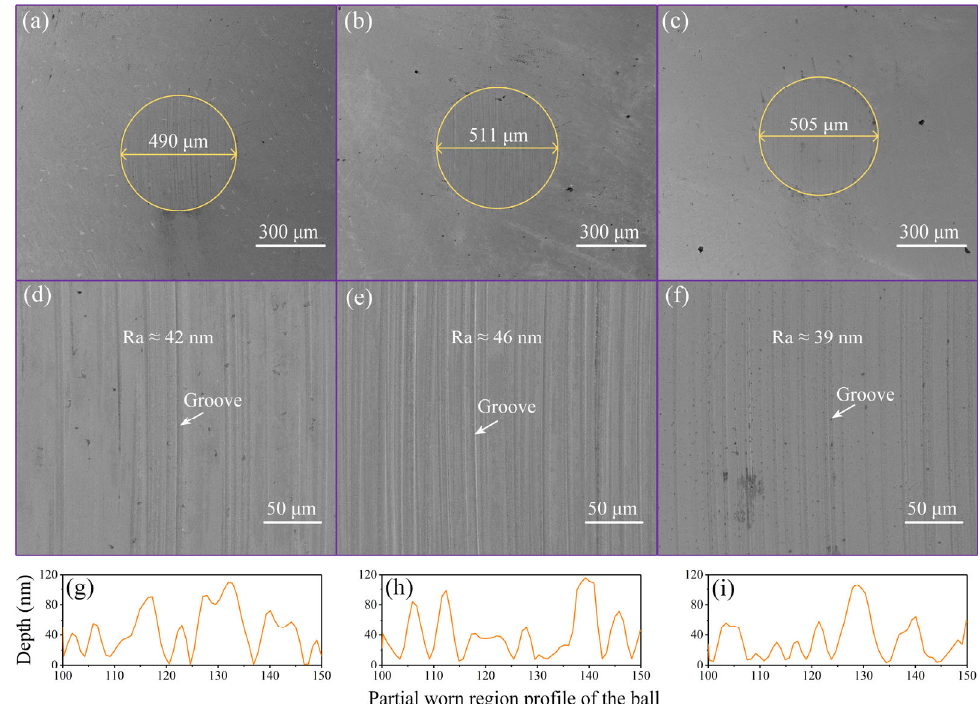
Fig. 3 SEM images of the worn regions on the steel balls that were lubricated with (a, d) PEG(aq), (b, e) PAG100 (the friction pairs were treated by PEG(aq)), and (c, f) PAO6 (the friction pairs were treated by PEG(aq)). (a–c) Overall perspectives and (d–f) detailed images of the worn regions. (g–i) Partial worn region profile of the balls obtained by a 3D white-light interferometry microscope: (g) lubricated with PEG(aq); (h) lubricated with PAG100 (the friction pairs were treated by PEG(aq)); and (i) lubricated with PAO6 (the friction pairs were treated by PEG(aq)). The normal load and sliding velocity were 3 N and 0.2 m/s,